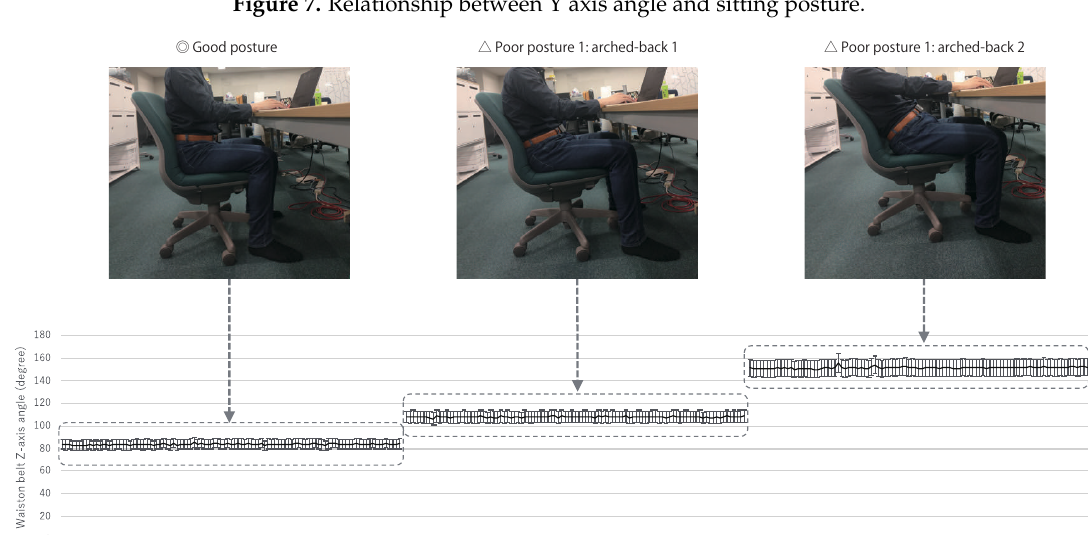
Figure 7. Relationship between Y axis angle and sitting posture.